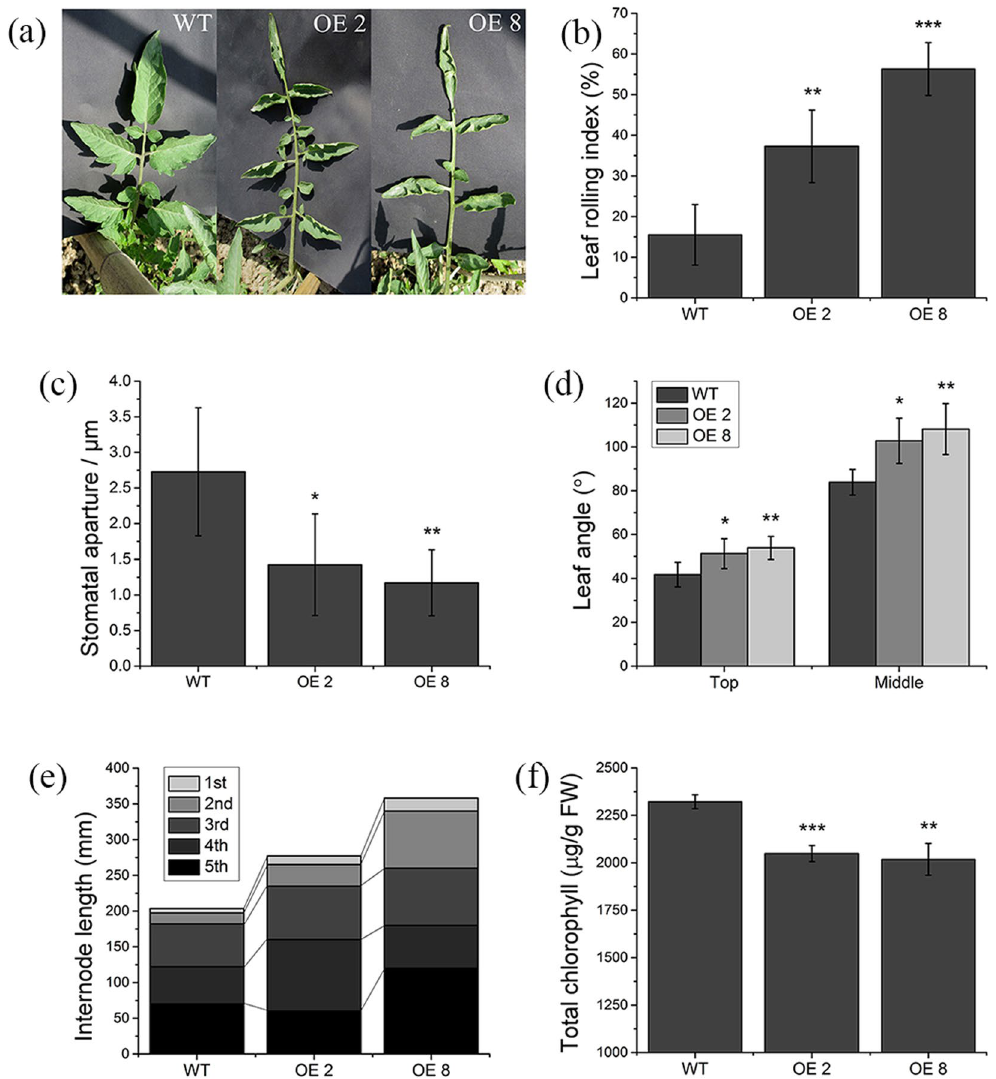
Figure 2. Phenotype of the SlPRE2 overexpression transgenic plants. ( a ) Leaf phenotype of wild type and transgenic lines. The 35 S:PRE2 transgenic lines showed rolling leaf trait. ( b ) Leaf rolling index (LRI) for the mature leaves. ( c ) Stomatal aperture of mature leaves on wild type and SlPRE2 overexpression lines. ( d ) Leaf tilt angle of the top young leaves and the middle mature leaves in wild type and transgenic lines. ( e ) The internode length for each of the top five internodes. ( f ) Chlorophyll content of leaves at the fifth from the top. Data are the mean ± SD of three biological replicates. * Significantly different from the wild type, P value t test < 0.05; ** for P <